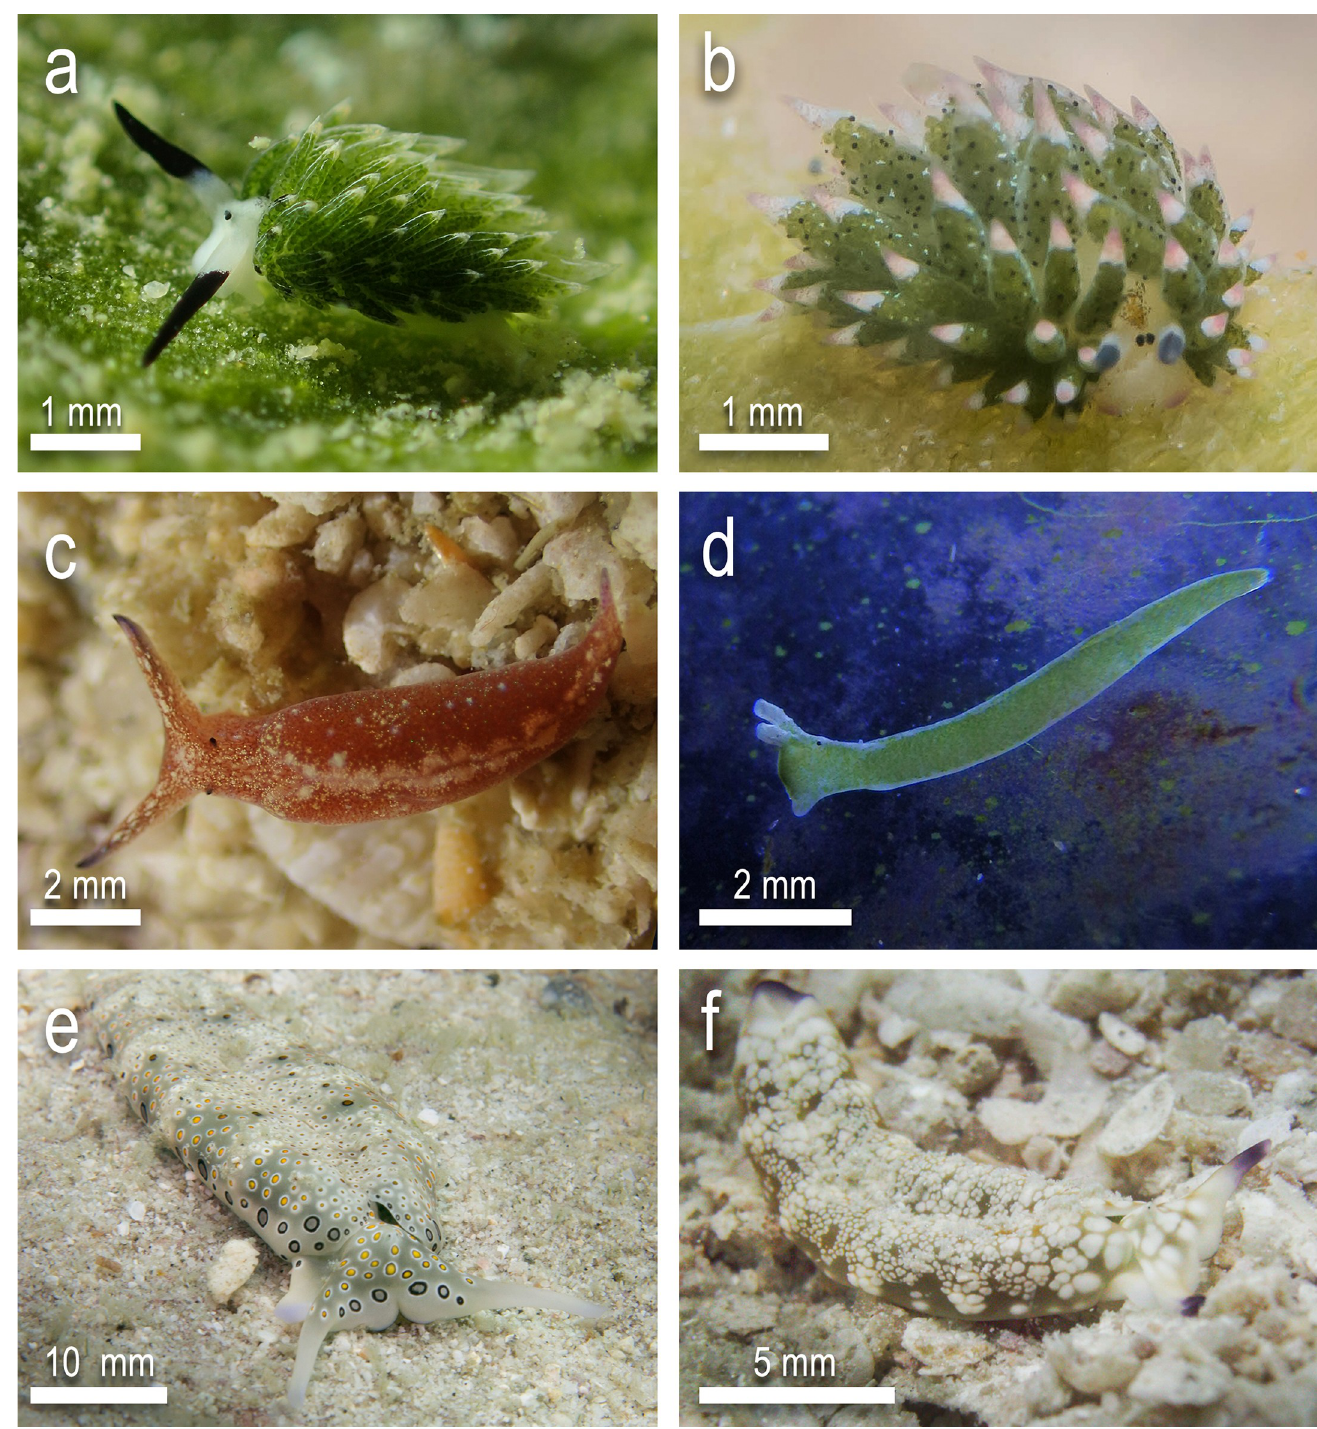
Fig 1. Prey species tested for consumption by corals. a) Costasiella usagi b) Costasiella cf. kuroshimae c) Elysia cf. japonica d) Elysia pusilla e) Plakobranchus cf. ocellatus f) Plakobranchus cf. papua